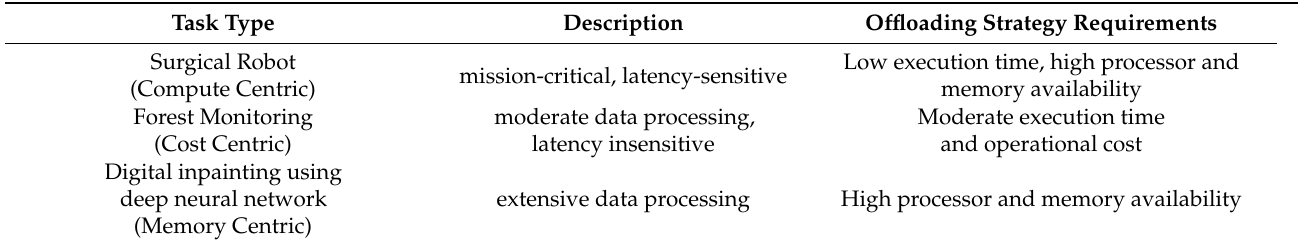
Table 1. Key offloading task strategy